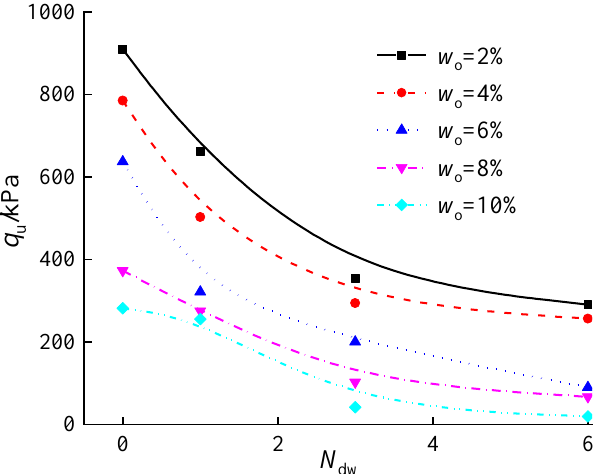
Figure 29. q u of stabilized silt under different dry – wet cycles and organic matter contents.